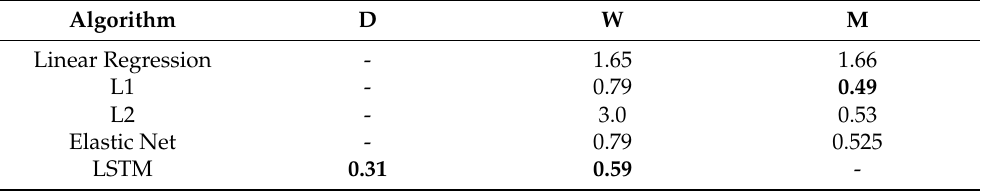
Table 3. Mean squared errors (MSE) obtained by the algorithms by using different data grouping modes for power-generation engine: 1 data/day (D), 1 data/week (W) and 1 data/month. The prediction horizons used were 10